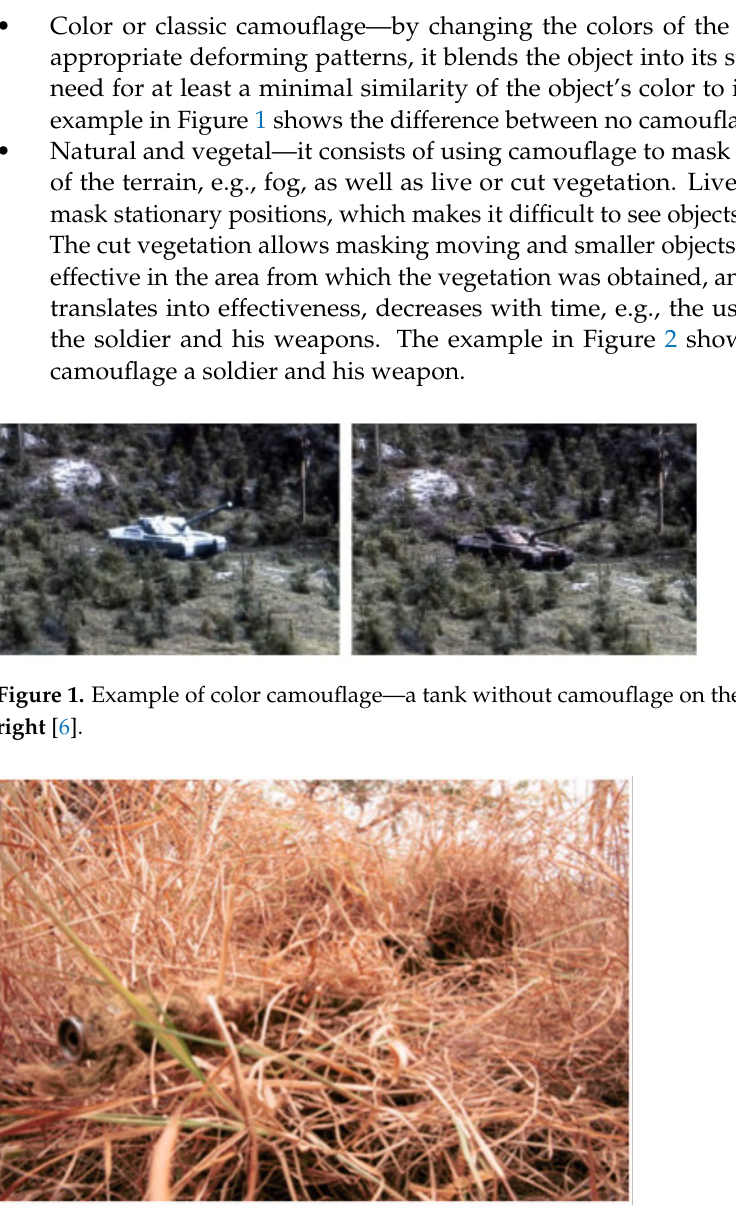
Figure 2. Example of vegetal camouflage—grass camouflage